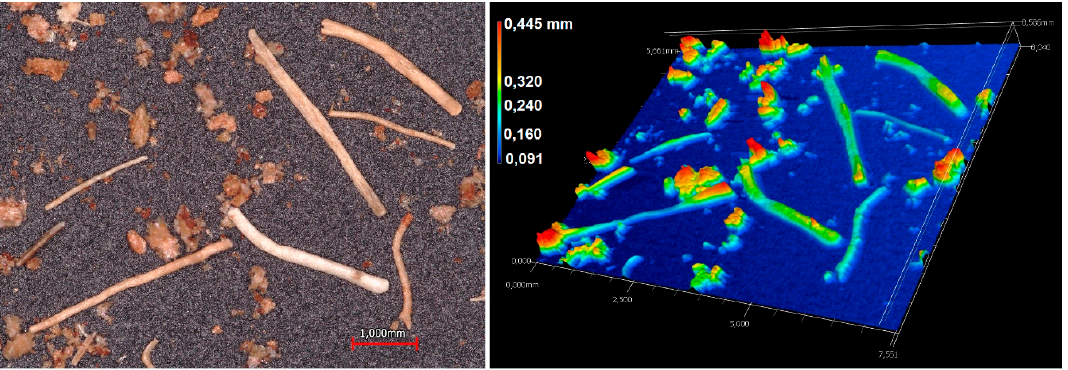
Figure 3. Optical micrograph and 3D height map of milled CCF.